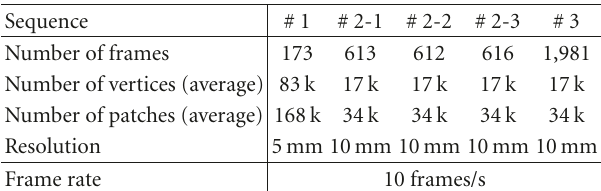
Table 1: Summary of 3D video utilized in experiments. Sequence #2-3 are Japanese traditional dances called #1 and sequences #2-1 (cid:0) bon-odori and sequence #3 is a Japanese warmup dance.